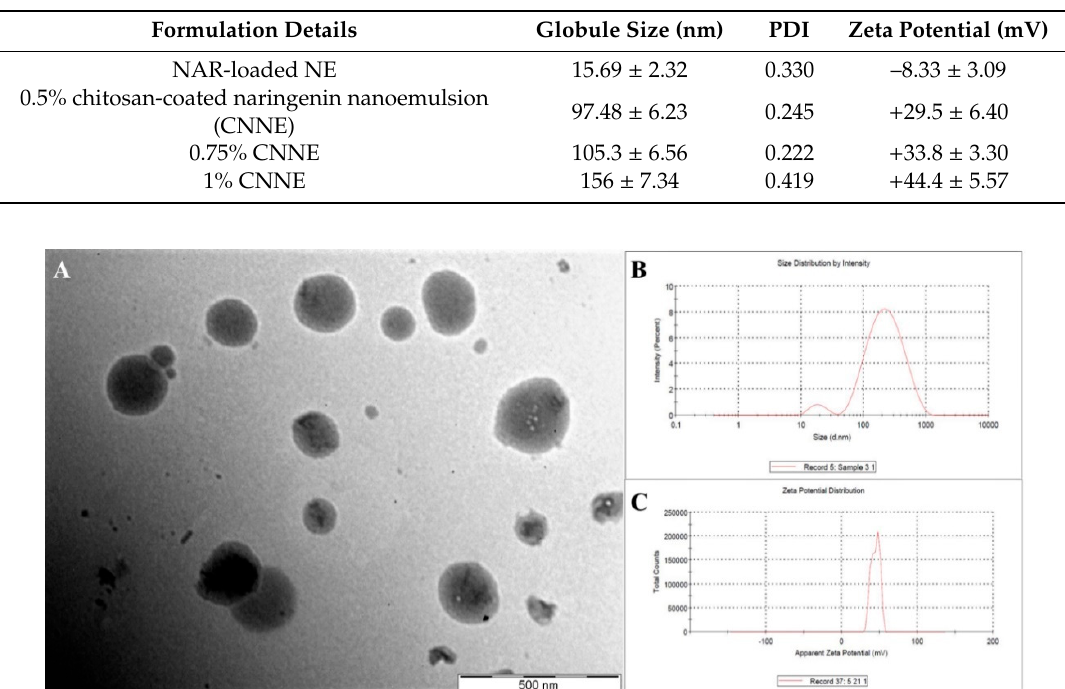
Table 5. Analysis of variance data for surface charge.